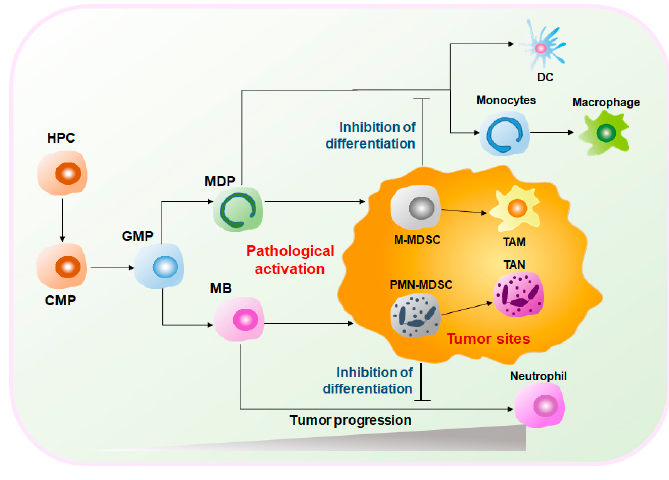
Figure 1. Differentiation and development of myeloid-derived suppressor cells (MDSCs) in the tumor microenvironment (TME). Under physiological conditions, neutrophils, dendritic cells (DCs), and monocytes originate from hematopoietic progenitor cells (HPCs) in the bone marrow. HPCs differentiate into granulocyte-macrophage progenitors (GMPs) after common myeloid progenitors (CMPs), and then GMPs differentiate into monocyte/macrophage and dendritic cell precursors (MDPs) and myeloblasts (MBs). Among them, MDPs are the precursors of DCs and monocytes, and MBs are the precursors of neutrophils. However, under pathological conditions, such as cancer, myeloid cells are induced to differentiate into suppressor cells, including monocytic myeloid-derived suppressor cells (M-MDSCs), tumor-associated macrophages (TAMs), polymorphonuclear myeloid-derived suppressor cells (PMN-MDSCs), and tumor-associated neutrophils (TANs). TME, tumor microenvironment; HPCs, hemopoietic progenitor cells; CMPs, common myeloid progenitors; GMPs, granulocyte-macrophage progenitors; MBs, myeloblasts; MDPs, monocyte / macrophage and dendritic cell precursors; M-MDSCs, monocyticmyeloid-derivedsuppressorcells;PMN-MDSCs,polymorphonuclearmyeloid-derivedsuppressor cells; TAMs, tumor-associated macrophages; TANs, tumor-associated neutrophils; DCs, dendritic